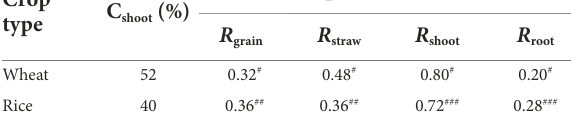
TABLE 2 C content of shoots and relative allocation coefficients of crop C to different parts of wheat and rice. Crop